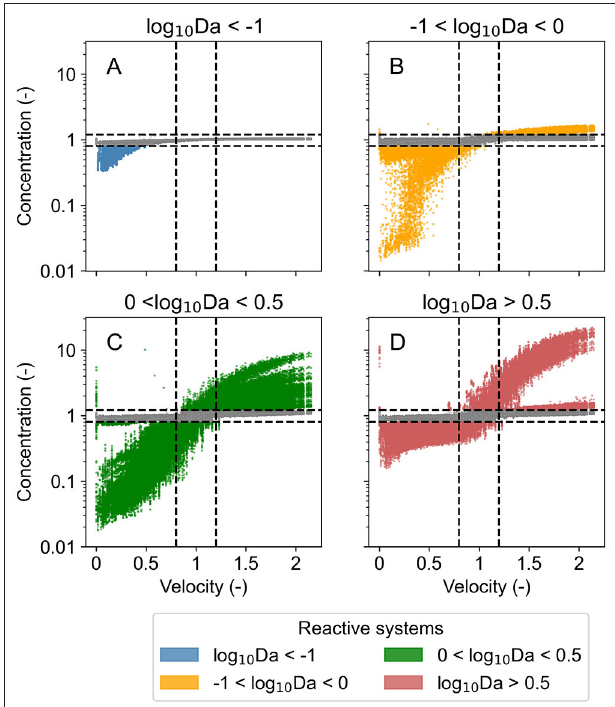
FIGURE 2 | Concentration of chemical species belonging to identified categories of reaction regimes in all investigated domains normalized by that in steady state conditions with changing normalized velocity in corresponding domain (velocity normalized by that in steady state conditions) over the entire simulation period of 15 years for the three investigated time series (T1, T2, and T5). Points are colored when the change in concentration is 20% or higher, otherwise points are gray. Dashed black lines mark a change of 20% in normalized concentration and in normalized velocity. (A) Displays data for transport dominant regimes, (B) for transport influenced regimes, (C) for reaction influenced regimes, and (D) for reaction dominant